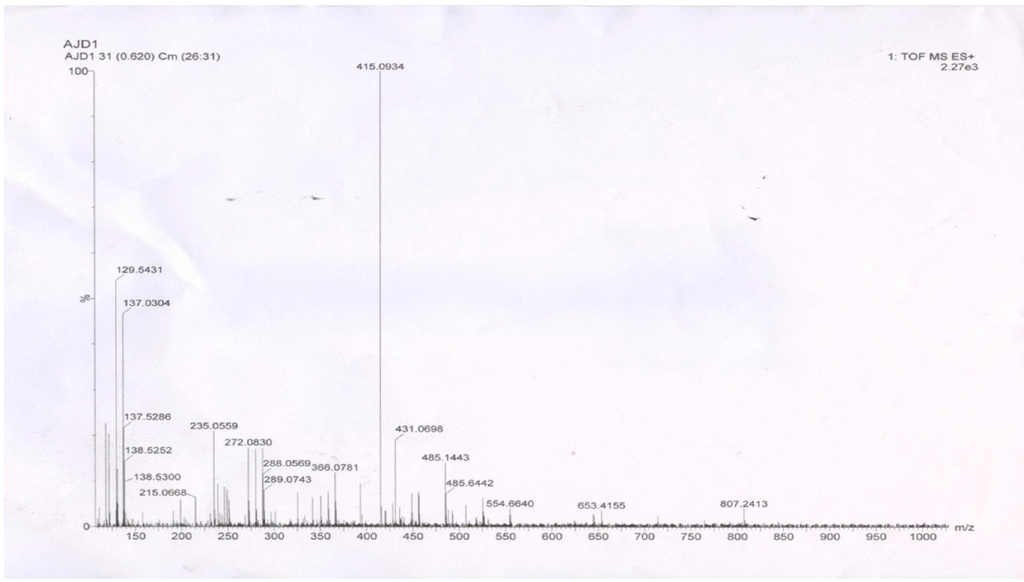
Figure 2. Spectrum of EPS sample.